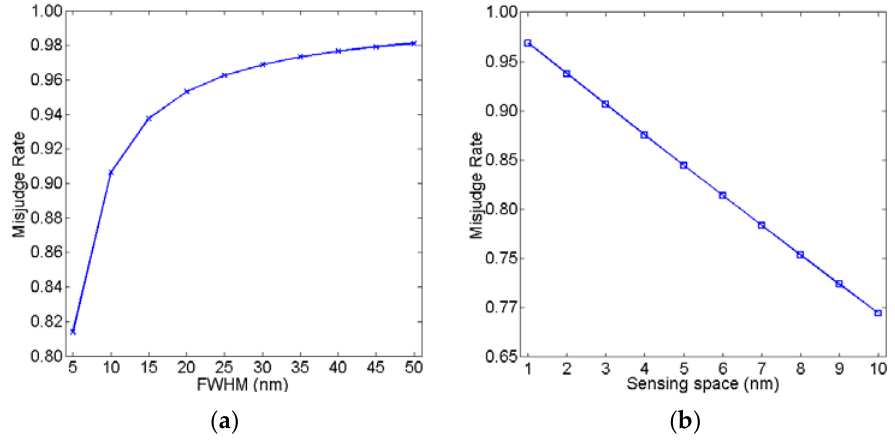
Figure 3. Misjudge rate as a function of ( a ) λ FWHM and ( b ) Δ λ , respectively.